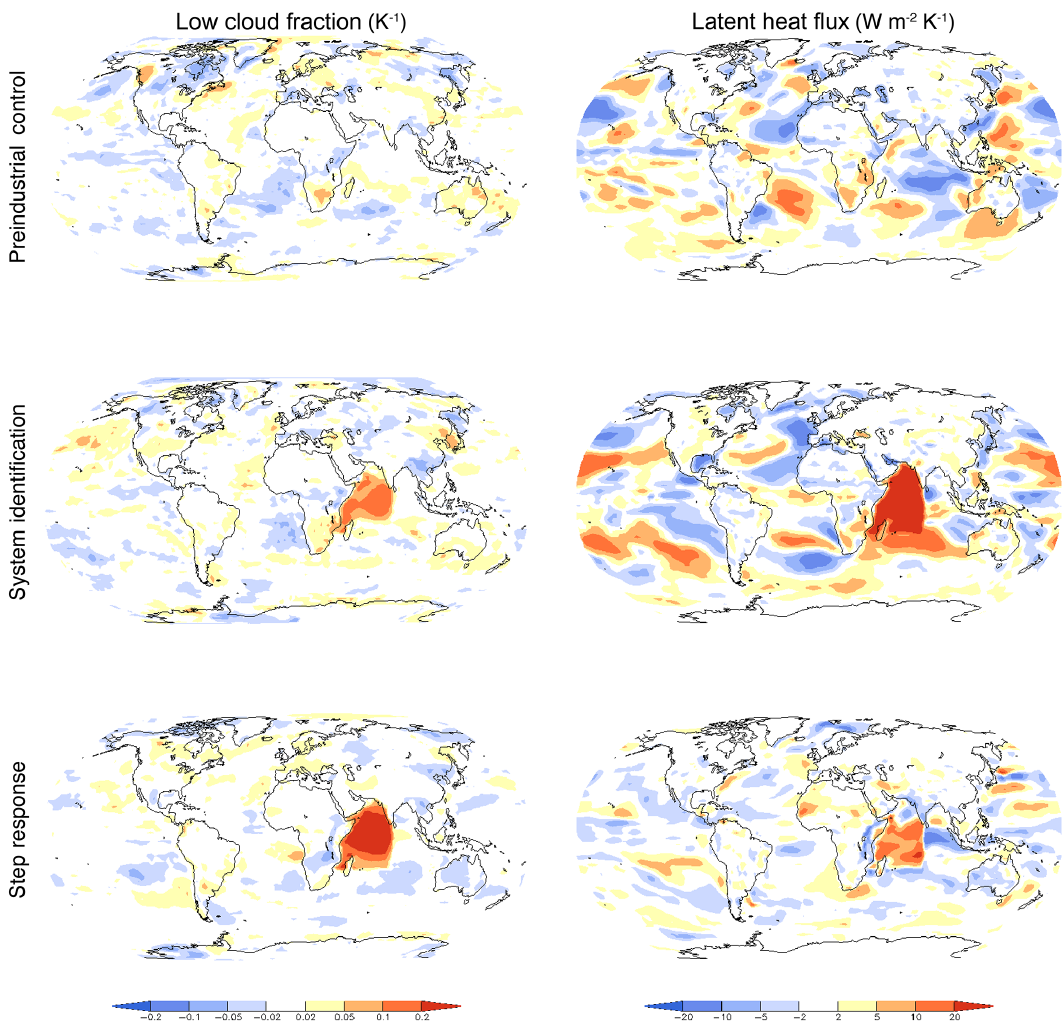
Figure 5. Steady-state response of low cloud fraction (left column) and latent heat flux (right column) for a 1K perturbation to the lowest model layer over the northwest Indian Ocean. Top row shows projections of the unperturbed preindustrial control simulation onto the input sequences; no response beyond climate system noise is expected. Middle row shows projections of the system identification (perturbed) simulations onto the input sequences (all 20 years of simulation). For comparison, the bottom row shows step response simulations in which the highlighted region has a sustained temperature increase over the 20-year simulation (values shown are averages over the entire 20-year period). Although somewhat noisy, the system identification simulations are capable of recovering the broad features of the step